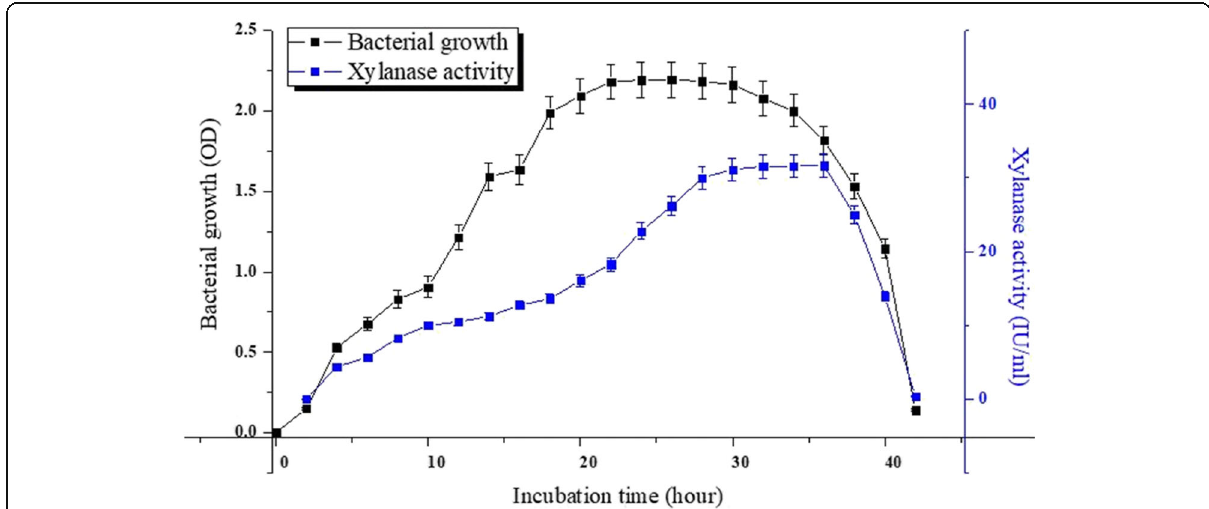
Fig. 3 Bacterial growth curve and xylanase activity of isolated xylanolytic bacteria SXB19. The bacterium was cultured in a xylan-enriched nutrient broth medium containing 0.5% of corn cob xylan and was incubated at 37